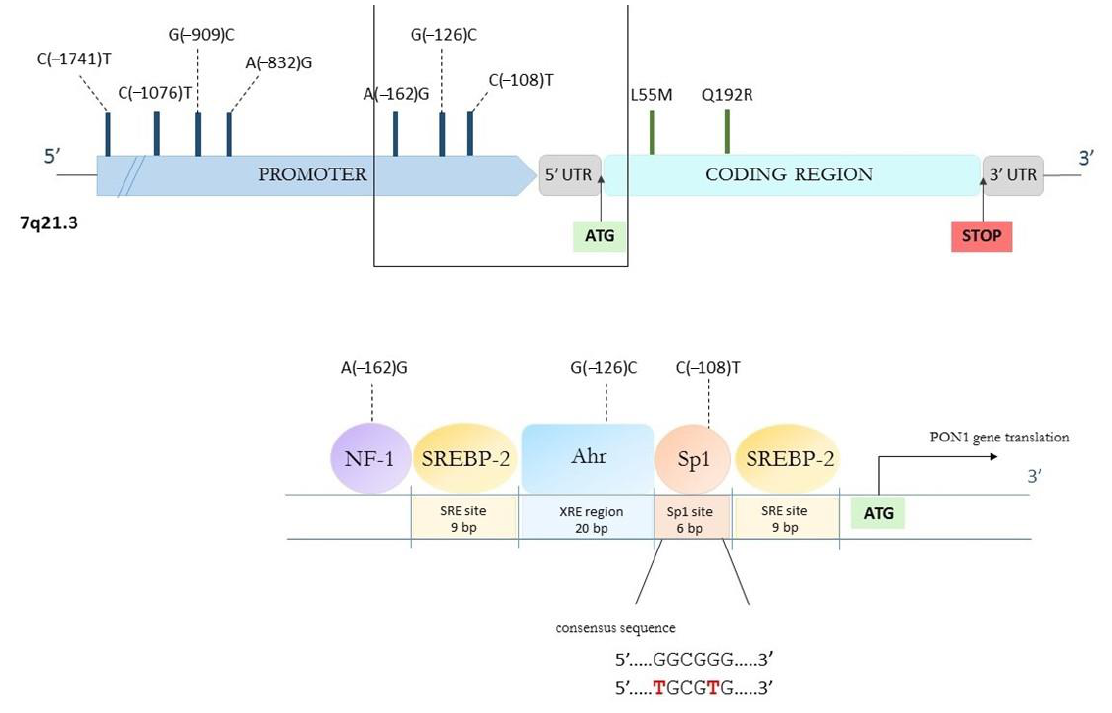
Figure 3. Polymorphic variants on PON1 gene promoter and coding region.